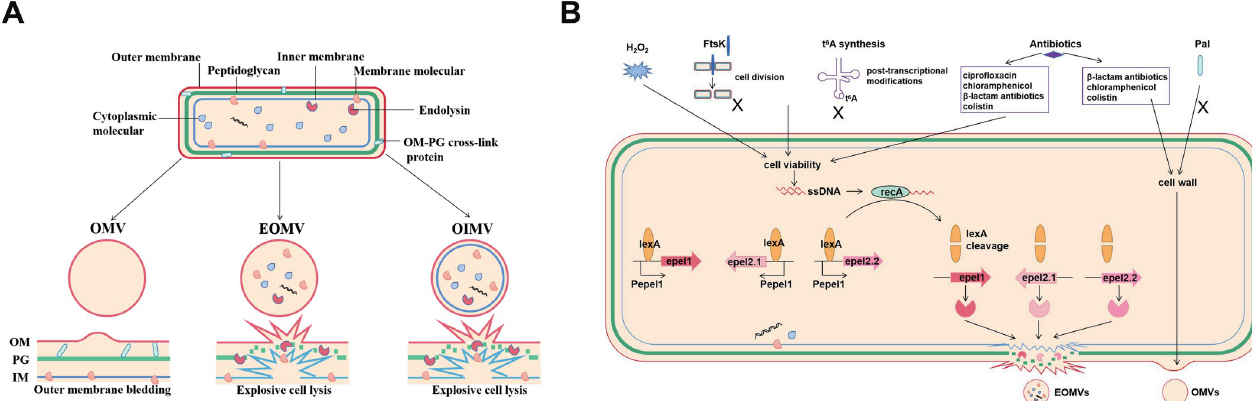
Fig 15. Illustration of the generation mechanisms of EVs in ExPEC. (A) The biogenesis mechanisms for different types ExPEC EVs. ExPEC EVs can be considered a mixture of classical outer-membrane vesicles (OMVs) and cytoplasm-carrying vesicles: explosive outer-membrane vesicles (EOMVs) and outer– inner-membrane vesicles (OIMVs). Therefore, typical OMVs, formed through the blebbing of the bacterial outer membrane from the envelope, have a single- layered membrane, which originated from the unbalanced biosynthesis of the cell envelope. A defect in the crosslinking between peptidoglycan and the outer membrane leads to the production of OMVs. The “explosive cell lysis” model is a possible mechanism for the formation of ExPEC EVs, in which the bacterial peptidoglycan is degraded by phage-derived endolysins to induce explosive cell lysis, and the broken membrane fragments gather and self-assemble to form EOMVs (single-layered membrane) or OIMVs (bilayer membrane). (B) Model of the generation mechanism of ExPEC cytoplasm-carrying vesicles. The unbalanced cell division caused by the deletion of the ftsK gene and t 6 A synthesis defects or by the toxicity caused by exposure to H 2 O 2 reduces ExPEC viability, thus increasing the production of cytoplasm-carrying vesicles through the RecA/LexA-dependent SOS response. Two regulatory proteins (RecA and LexA) control the expression of the SOS response genes in E . coli . This study demonstrated that the repressor LexA directly suppresses the expression of endolysins (Epel1, Epel2.1, and Epel2.2) by binding to the SOS boxes in the endolysin promoter regions. In response to DNA damage, the binding of RecA to single- stranded RNA activates RecA to stimulate the autocatalytic cleavage of the LexA repressor. The expression of prophage-associated endolysins is then activated, which triggers cell lysis and increases the production of ExPEC cytoplasm-carrying vesicles. Antibiotic treatment also reduces bacterial viability, thus increasing the production of ExPEC cytoplasm-carrying vesicles through the RecA/LexA-dependent SOS response. In contrast, the deletion of pal only causes a peptidoglycan crosslinking defect, which promotes the formation of classic